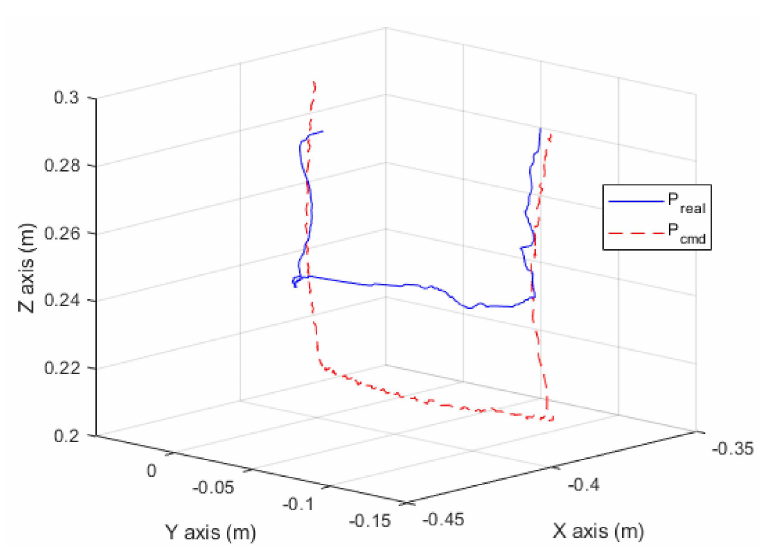
Figure 18. Trajectory of the robot arm in the wiping